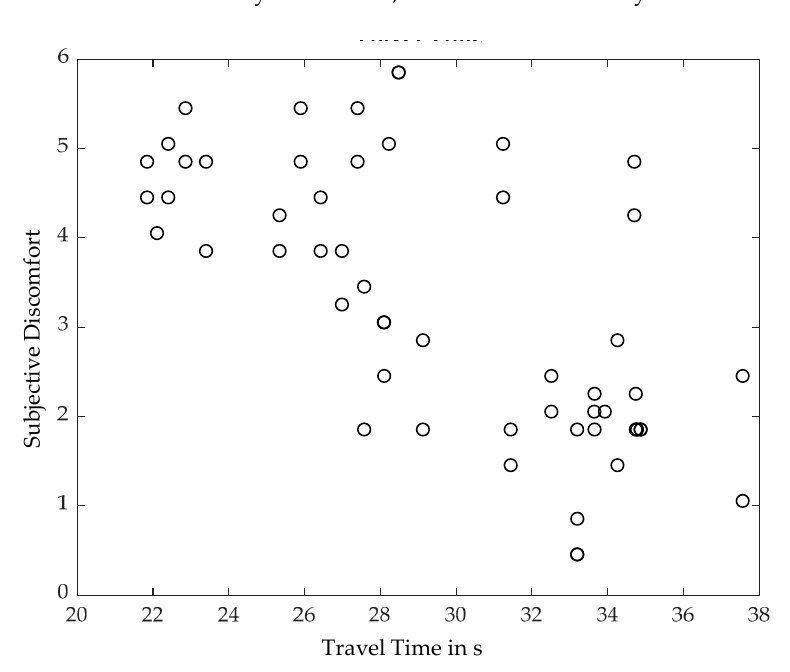
Figure 9. Dependence between user discomfort and travel time in Maneuver B .